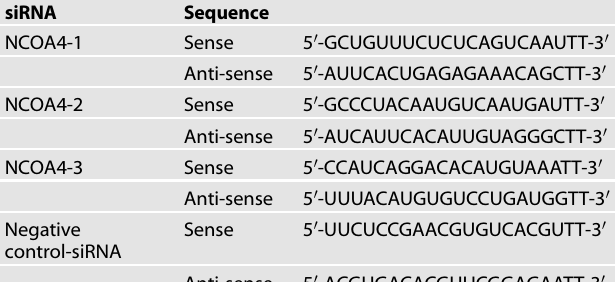
Table 1. siRNA sequence of